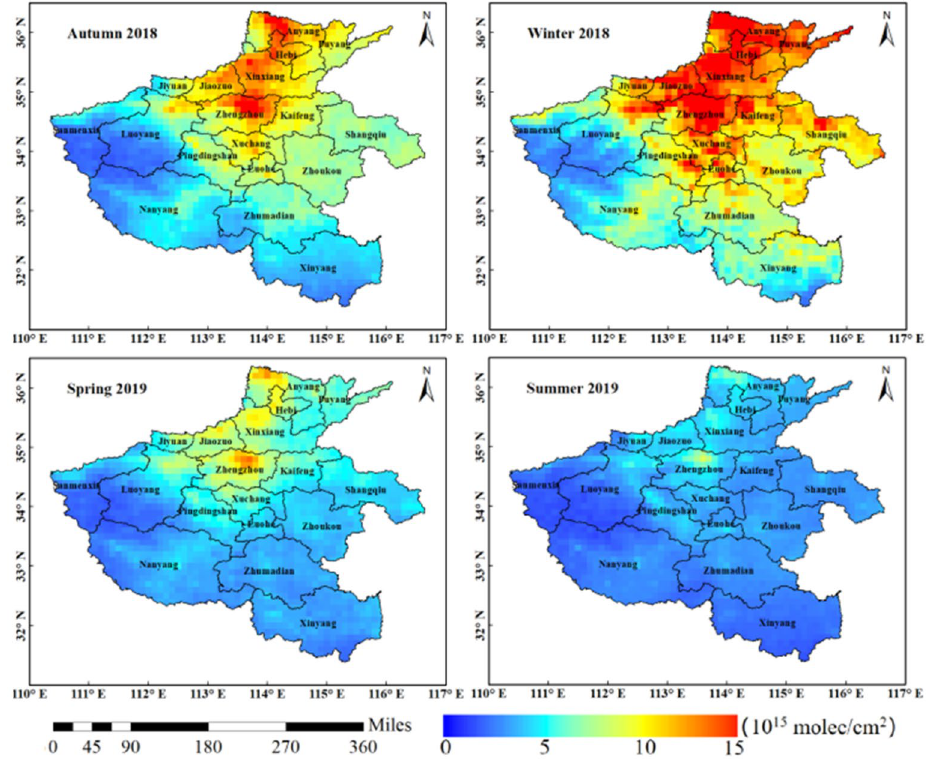
Figure 7. Seasonal mean distribution of TROPOMI NO 2 VCDs (× 10 15 mol/cm 2 ) of the COVID-19 early period from August 2018 to September 2019 in Henan Province.